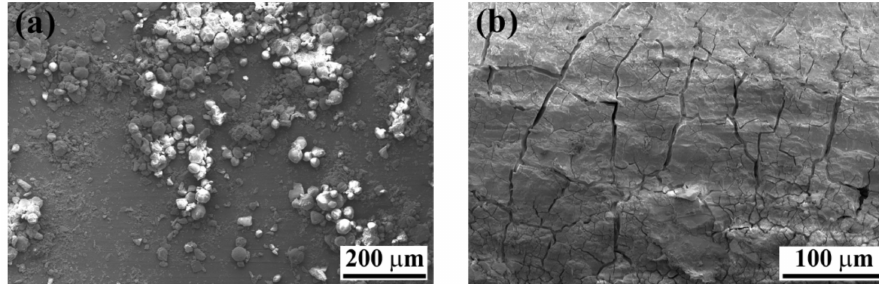
Figure 18. SEM images of the fracture surface of the SB specimen on the composite side after 12 months of outdoor weathering. ( a ) high-magnification image from the area (4) in Figure 16c, and ( b ) high-magnification image from the area (5) in Figure 16c.